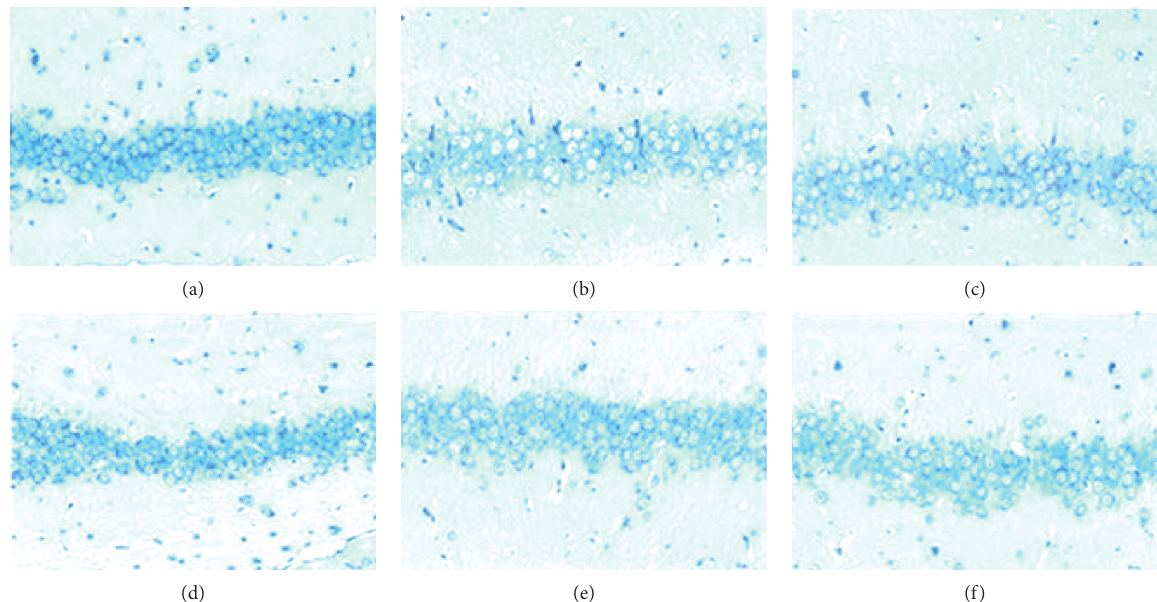
Figure 1: Influence of texture parameters on friction factor at different temperatures. (a) 30 ° C. (b) 35 ° C. (c) 38 ° C. (d) 40 ° C. (e) 43 ° C. (f) 50 ° C.